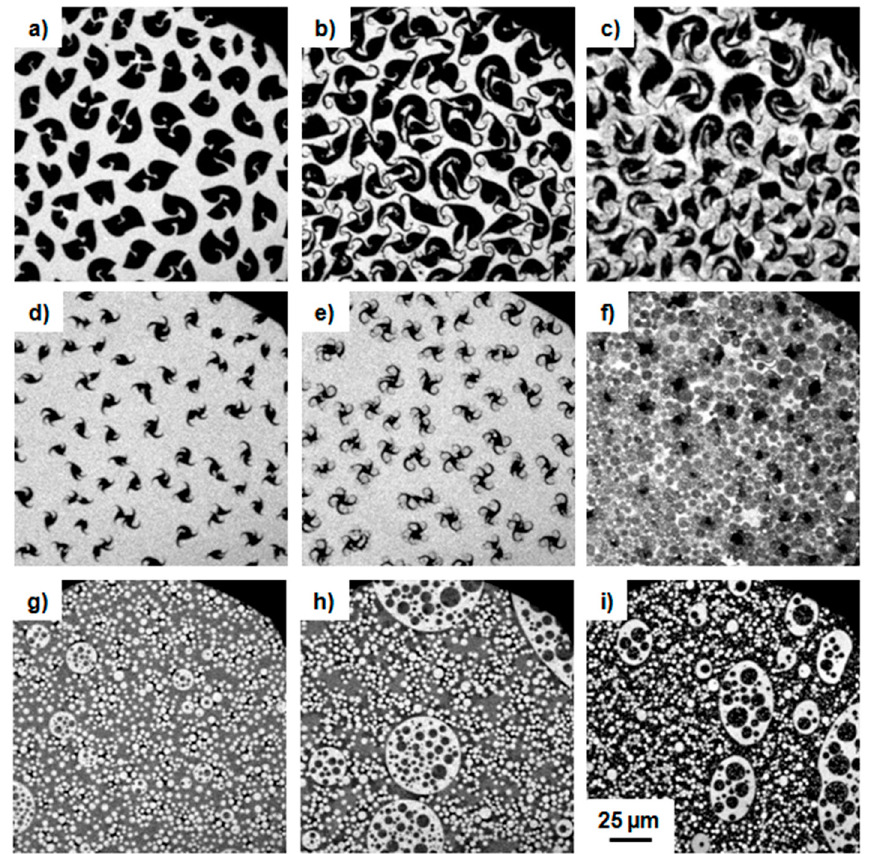
Figure 3. Epifluorescence microscopy images of monolayers of DPPC/ 5 with different molar ratios ( a – c ) 99.5:0.5, ( d – f ) 99:1, and ( g – i ) 90:10 at the air–water interface at 20 °C. The images